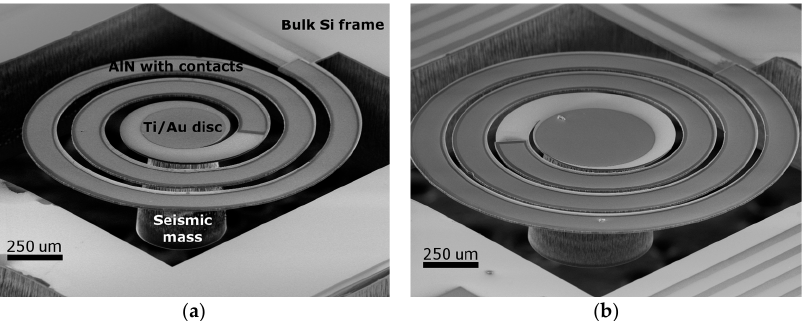
Figure 4. Tilt-view scanning electron microscope (SEM) images of two typical suspended spiral-shaped cantilevers (1,3) ( a ) and (3,4) ( b ) with contacted AlN layer (darker region) on their top surfaces, and a wafer thick 3D-micromachined Si seismic mass beneath. The darker circle in the center corresponds to a Ti/Au disc applied for laser reflection tests. Truncated shape of the tip mass is due to the increasing underetching ratio during the DRIE.